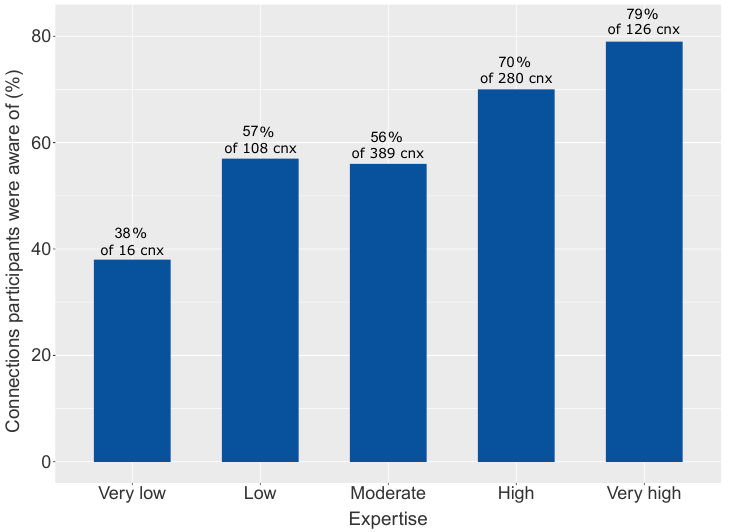
Figure 4. Number of times participants indicated to be aware of connections being made by the apps according to their expertise in computer networks. Participants with a higher expertise indicated to be more aware on average about the connections made by the apps installed on their devices. Of the 321 insecure connection pairs ( ( network , app ) pairs containing both an insecure Wi-Fi network and an unencrypted connection made by the app), participants responded for 292 cases